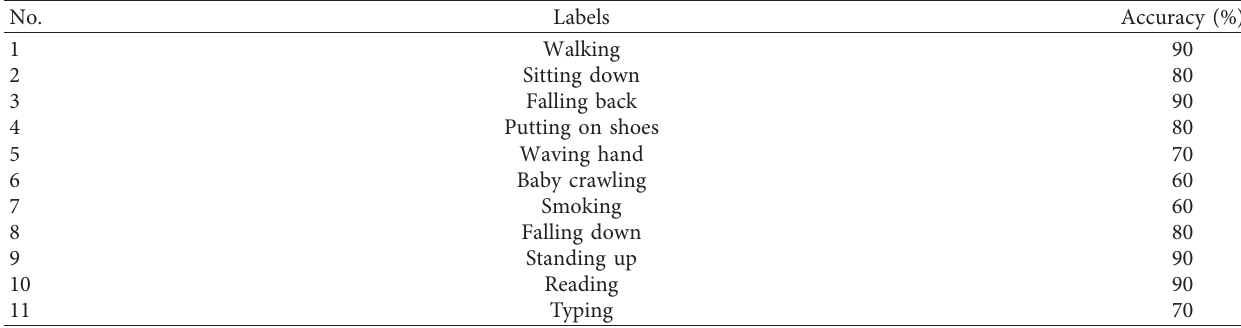
Table 4: Tensorflow Lite results.